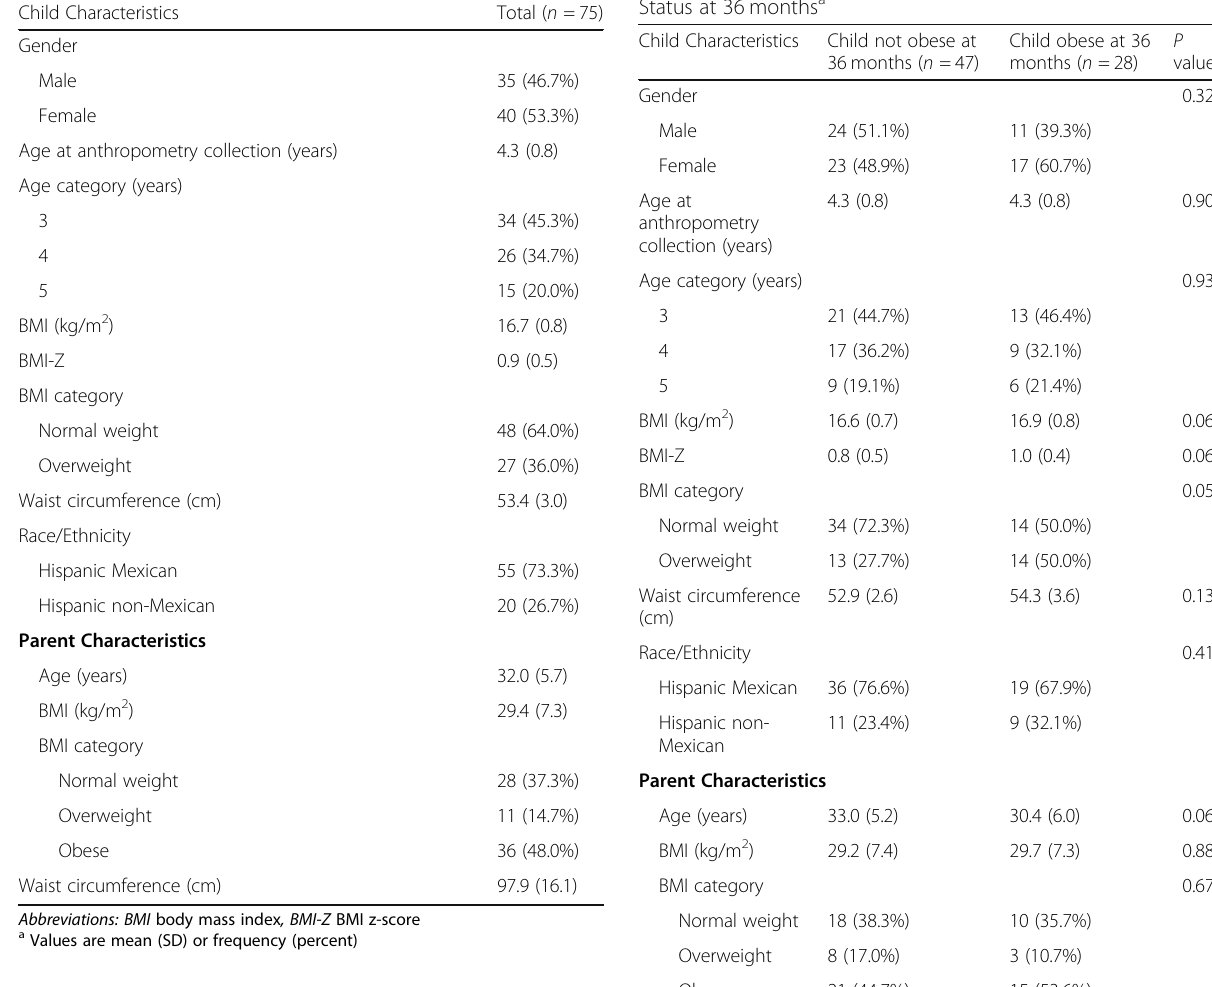
Table 2 Baseline Participant Characteristics by Child